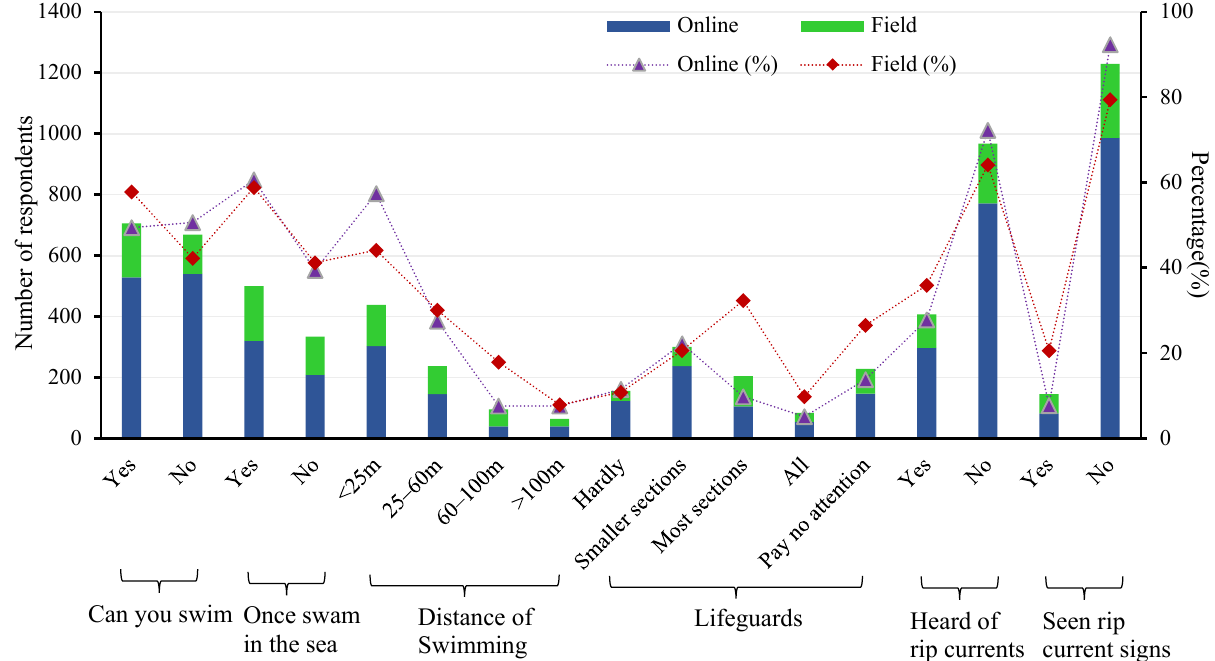
Figure 7. Respondents’ swimming ability and awareness of rips, and the distribution of beach lifeguards from the respondents’ responses. The bar chart indicates the number of respondents, and the line chart indicates the percentage of each indicator.